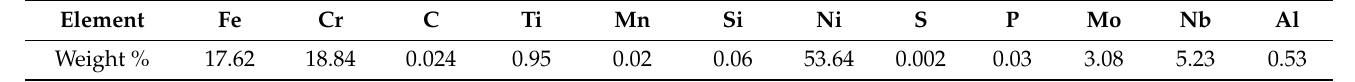
Table 1. Nominal chemical composition of Inconel 718